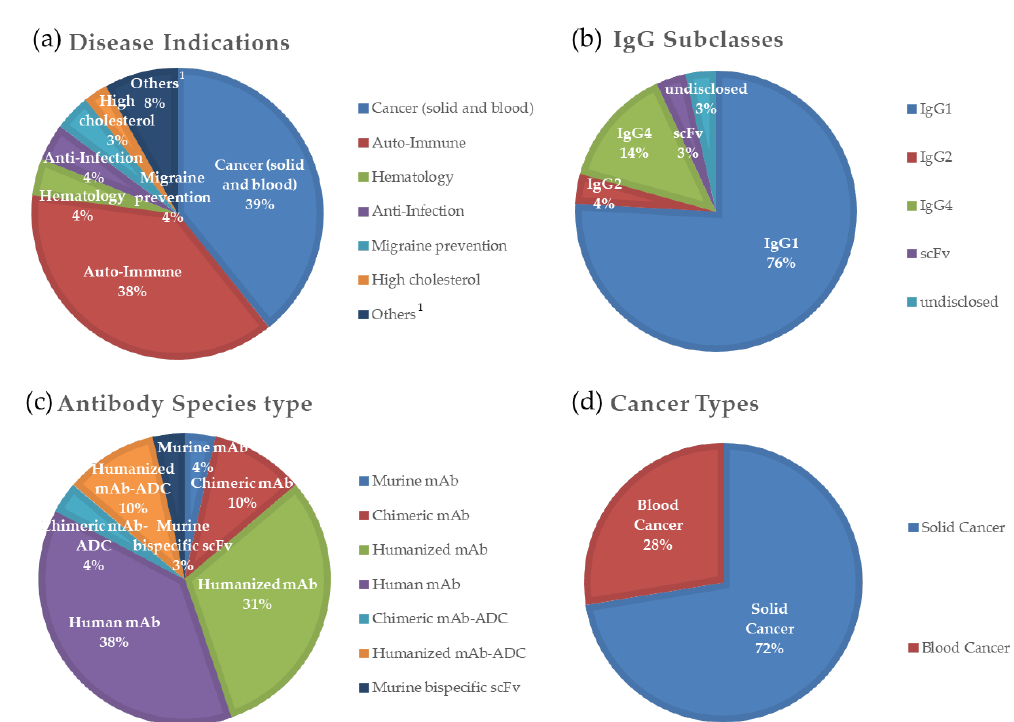
Figure 1. Indication and molecular types of therapeutic antibodies approved by the US FDA and EMA, classified by ( a ) disease indications of all 74 therapeutic antibodies; ( b ) antibody subclasses of 29 antibodies for cancer; ( c ) species type of 29 antibodies for cancer, i.e., murine, chimeric, humanized, or fully human; and ( d ) cancer types of 29 antibodies for cancer (blood or solid cancer). These figures were classified using data from “The Antibody Society (2020)” [2]. 1 Others in panel ( a ) include prevention of kidney transplant, macular degeneration, Muckle – Wells syndrome, bone loss, high cholesterol, X-linked hypophosphatemia, and osteoporosis in postmenopausal women at increased risk of fracture. Table 1. Molecular properties of IgG antibody subclasses.